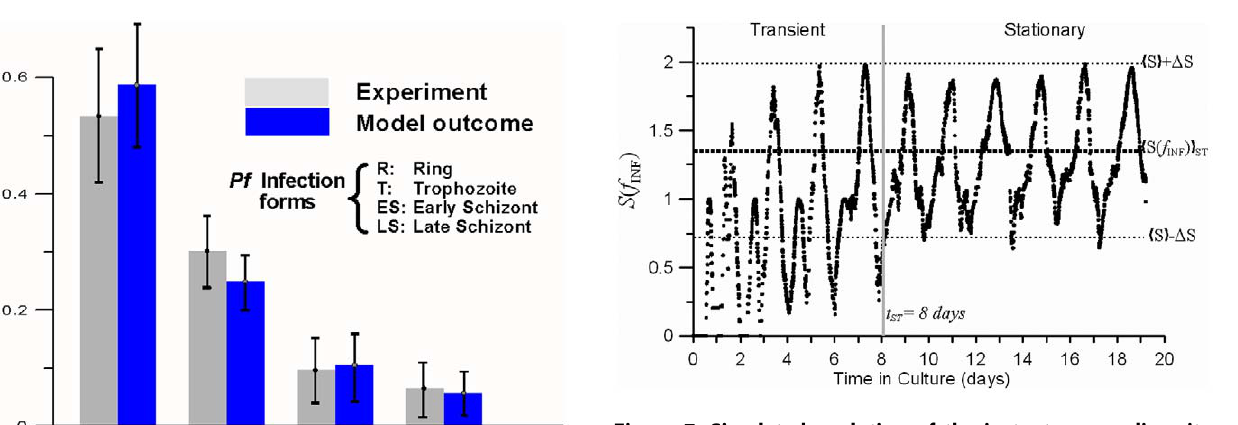
Figure 7. Simulated evolution of the instantaneous diversity index of infection forms S f (t) . S f (t) is compared to the prevalent diversity observed in experimental cultures , S(f INF ) . ST . During the stationary state ( t ST § 8 days ), S f (t) is circumscribed within the standard deviation D S found when examining several experimental cultures operating at standard